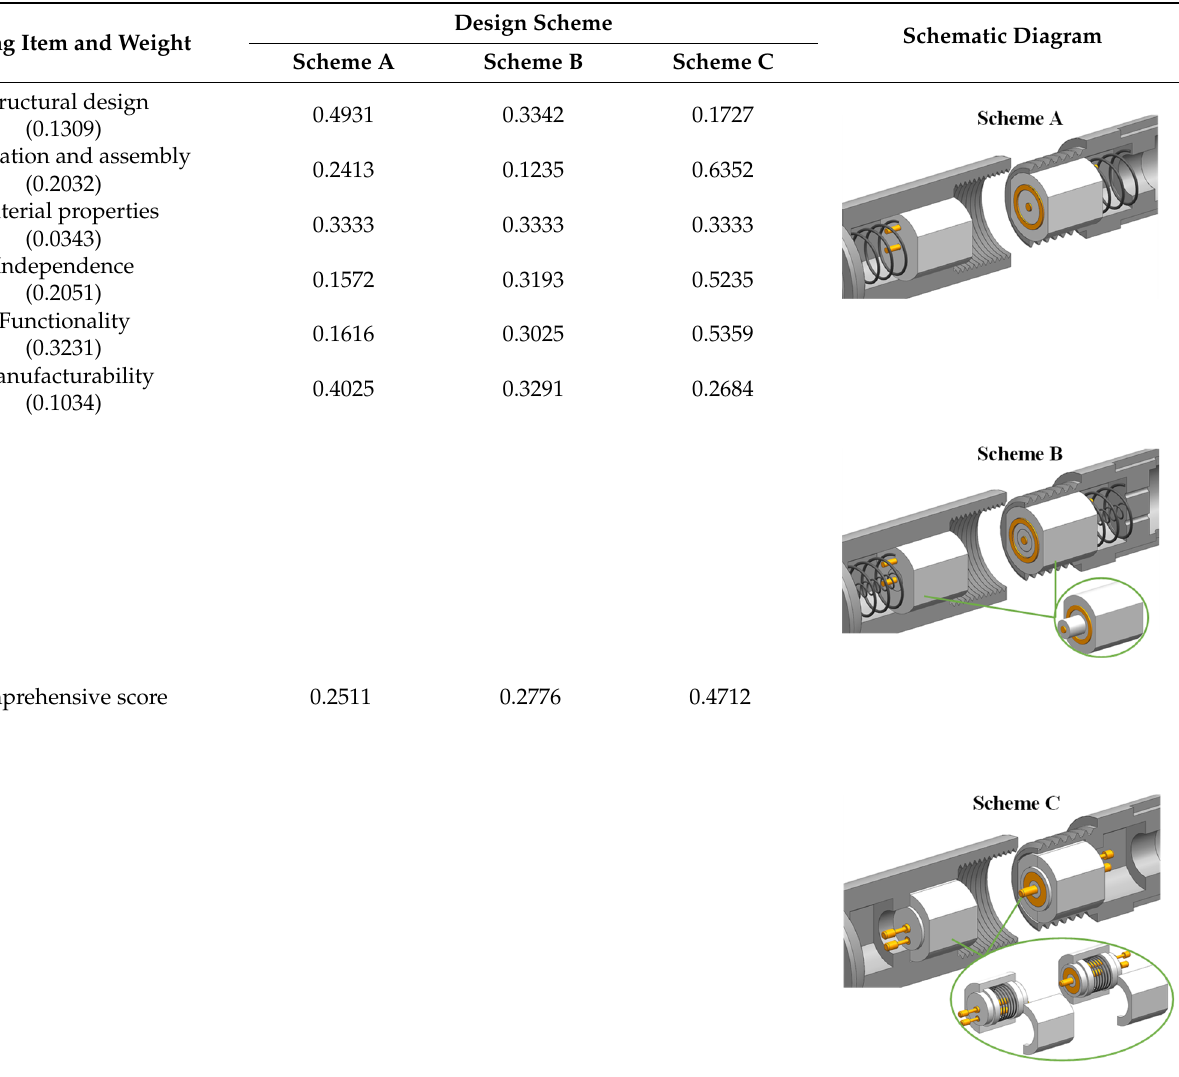
Table 4. Comprehensive evaluation of the optimized conductive center pole.